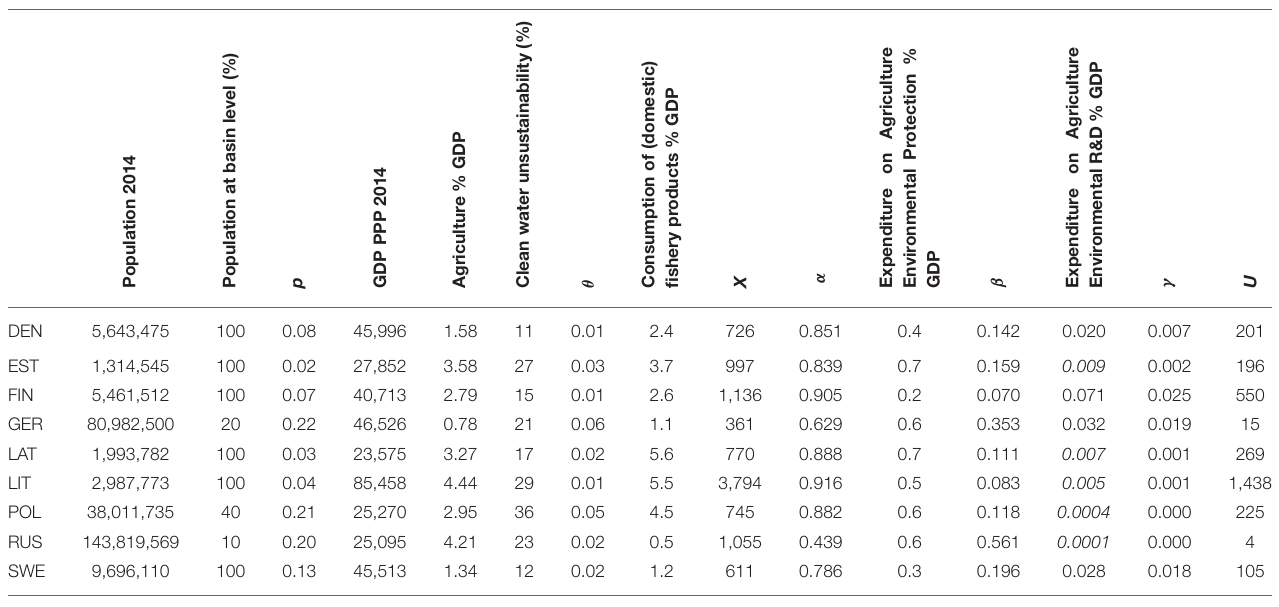
TABLE 3 | The dataset for the case study in the Baltic